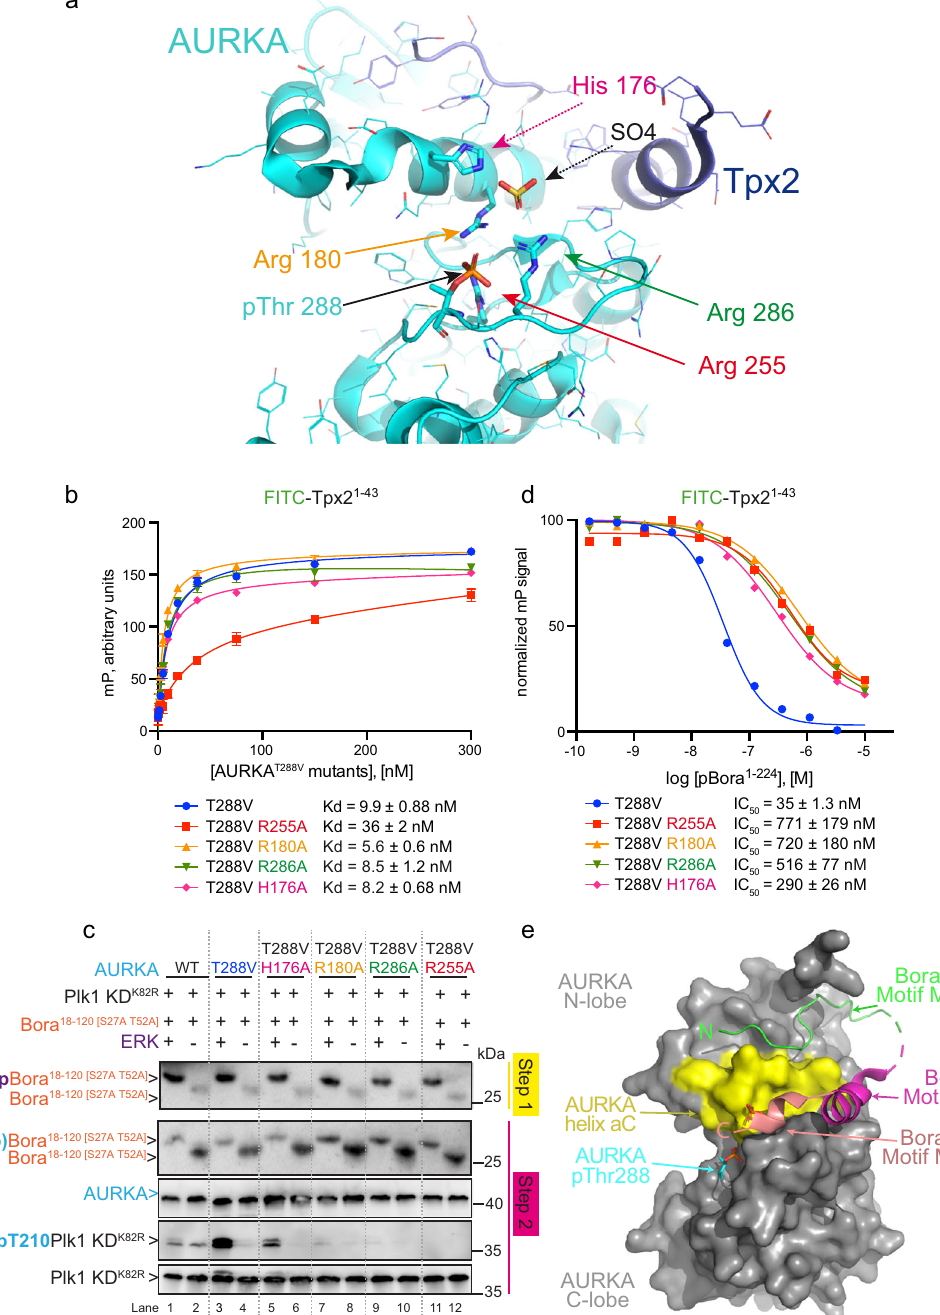
Fig. 7 Bora binds AURKA through two Tpx2-like motifs that position a phospho-motif in the kinase active site. a Zoom-in view of the binding interface between Tpx2 and AURKA (PDB: 1OL5). The T-loop phospho-residue Thr288, sulfate ion (yellow), and the phospho-T-loop and sulfate ion coordinating residues of AURKA (H176, R180, R255, and R286) are highlighted in stick representation. b Binding of fl uorescein-labeled Tpx2 1 – 43 polypeptide to AURKA mutants assessed by monitoring the fl uorescence polarization signal in the presence of increasing concentrations of AURKA mutants. K d values represent mean value with standard deviations of the mean as error bars ( n = 3 independent experiment samples). c Western blot analysis of 2-step kinase reactions carried out with Bora 18-120[S27AT52A] phosphorylated ( + ) or not ( − ) by the ERK kinase (step 1) in the presence of Plk1 K82R KD (substrate) and AURKA WT or mutated versions as indicated (step 2). Blots were probed with antibodies to Bora, AURKA, and phosphoT210 Plk1 or pan Plk1 as indicated (from top to bottom). d Competitive displacement of fl uorescein-labeled Tpx2 1 – 43 from the indicated AURKA mutants by increasing concentrations of pBora 1 – 224 as monitored by fl uorescence polarization. Displayed data points and the half maximal inhibitory concentration (IC 50 ) value represent the average normalized fl uorescence polarization signal for each reaction conditions (starting binding signal = 100%, end titration binding signal = 0%) ( n = 3 independent experiment samples). e Theoretical/illustrative model of pBora binding to the kinase domain of AURKA. AURKA is shown in gray surface with helix α C highlighted in yellow. Bora motifs M1 (blue) and M2 (purple) were modeled by two corresponding motifs from Tpx2 and the phospho-motif M3 (pink) was modeled by the TSS motif from